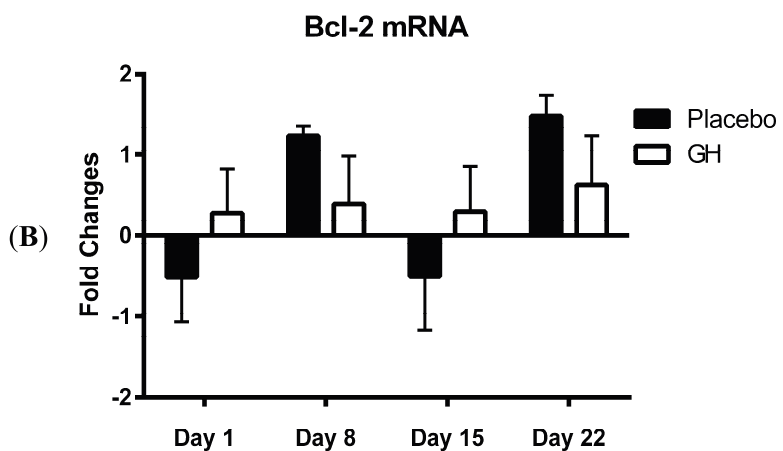
Figure 2. ( A ) Changes from baseline measurements in the expression of Bak mRNA levels from PBMCs in rhGH treated compared to placebo treated samples; ( B ) Changes from baseline measurements in the expression of Bcl-2 mRNA levels from PBMCs in rhGH treated compared to placebo treated